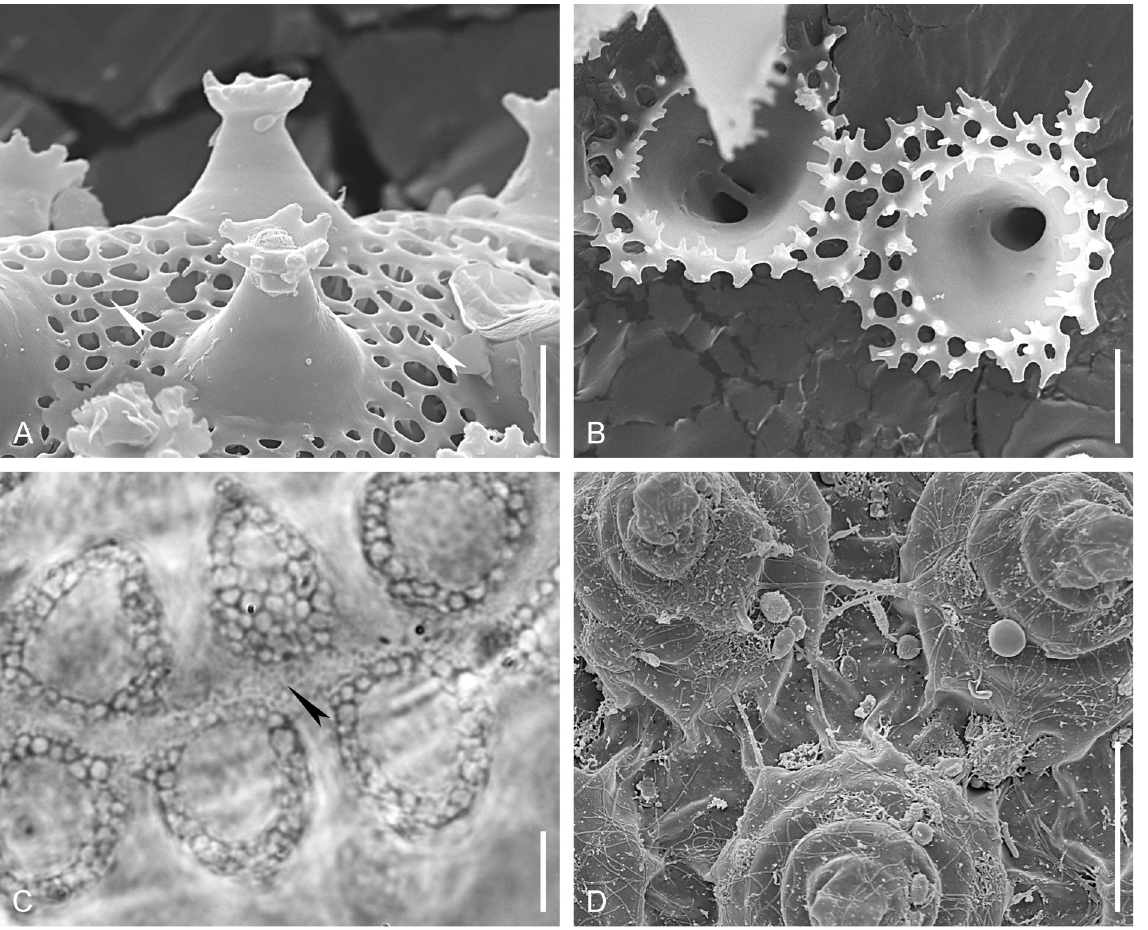
Fig. 10. Details of the egg shell structure in macrobiotidae. A. Egg shell surface of Macrobiotus cf. sottilei Pilato, Kiosya, Lisi & Sabella, 2012, white arrowheads indicate the internal pillars of the egg shell, SEm. B . Fragment of the outer shell layer of M . cf. sottilei egg visible from inside, with numerous pillars, deriving from the lower surface of the reticulated outer layer, SEm. C . Fragment of the egg surface of Tenuibiotus voronkovi (Tumanov, 2006) with granulation-like pattern visible between the egg processes (SPbu 205(4)), PhC. D . Fragment of the egg shell of T. voronkovi in SEm, note the absence of the surface granulation. Scale bars: A–B = 2 µm; C–D = 5